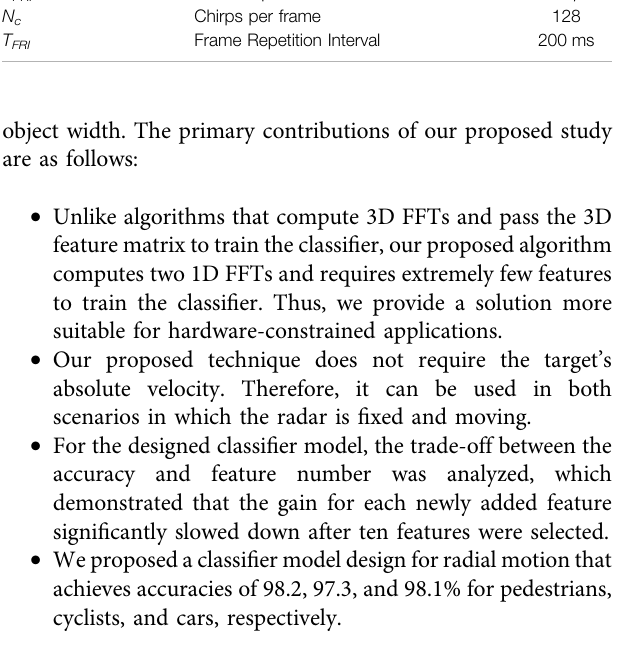
Frontiers in Signal Processing |